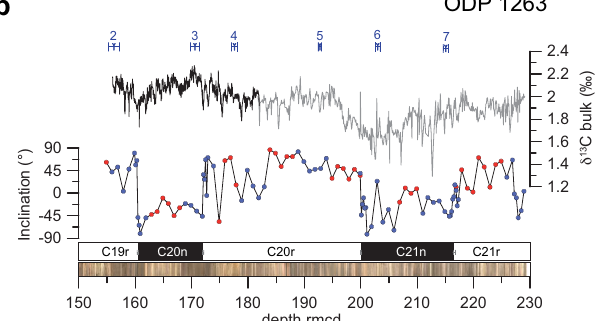
Figure 2. Overview of data from ODP Hole 702B and Site 1263 generated during this study. (a) Bulk stable carbon (black) data gen- erated by this study, inclination data (gray; Clement and Hailwood, 1991), magnetostratigraphic interpretation, core ID and core images vs. depth. (b) ODP Site 1263 data generated by this study vs. revised composite depth: bulk stable carbon isotope data (black: Bremen lab; gray: Santa Cruz lab), inclination data (red dots: 1263A; blue dots: 1263B), magnetostratigraphic interpretation and core images. Numbers with error bars mark calcareous nannofossil events (2, 4): 1, base R. umbilicus > 14µm; 2, top Nannotetrina spp.; 3, top N. fulgens ; 4, top C. gigas ; 5, base C. gigas ; 6, base N. fulgens ; 7, top D. lodoensis